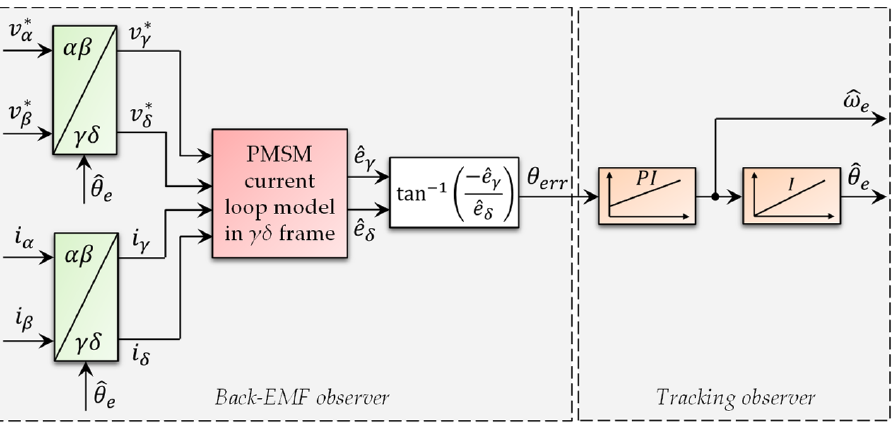
Figure 12. Back ‐ EMF and tracking observer with PLL mechanism. Figure 12. Back-EMF and tracking observer with PLL